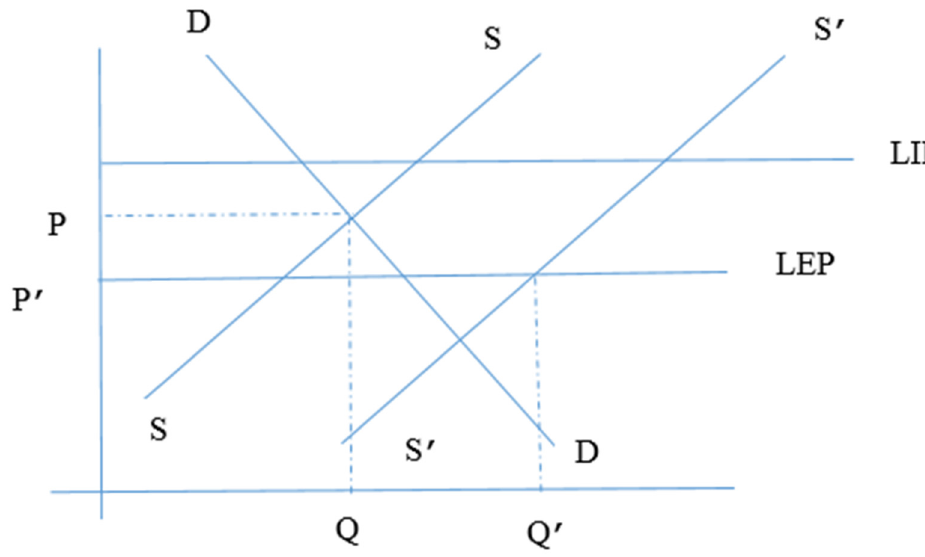
Figure 2. Low transfer costs and an exporting economy for the local market.